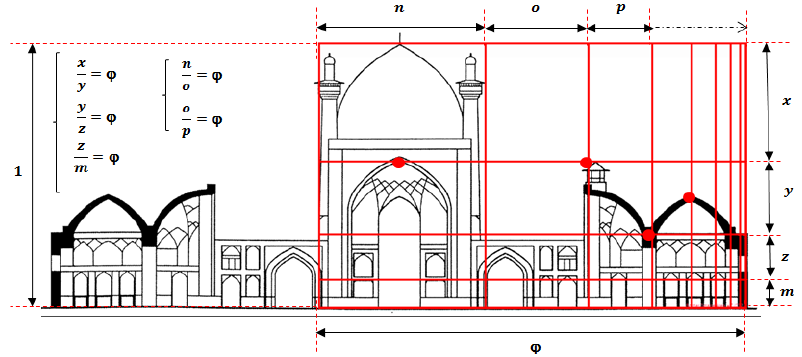
Figure 15: Adaptation of vertical gold lines with important points Table 2: Result of the section analysis Range of study Obtained golden